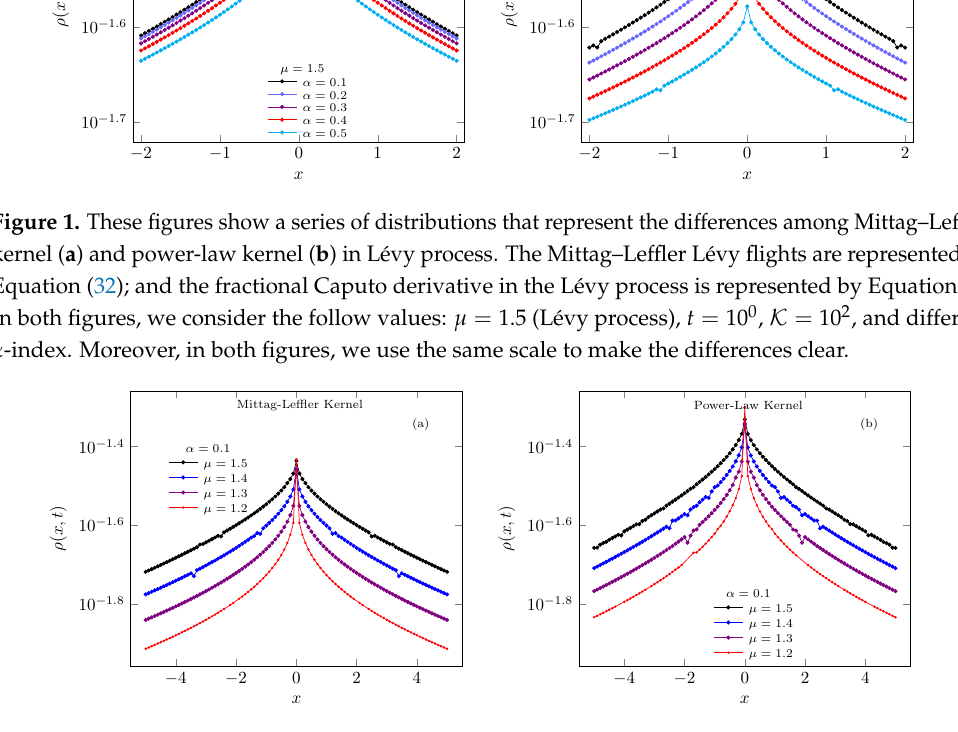
Figure 2. These figures show a series of distributions that represent the differences among Mittag–Leffler kernel ( a ) and power-law kernel ( b ) in Lévy process. The Mittag–Leffler Lévy flights are represented by Equation (32); and the fractional Caputo derivative in the Lévy process is represented by Equation (4). In both figures, we consider the follow values: α = 0.1 (fractional dynamic in the time), t = 10 − 2 , = 10 2 , and different µ -index (to µ = 2 we have Lévy process). Moreover, in both figures, we use the K (cid:54) same scale to make the differences